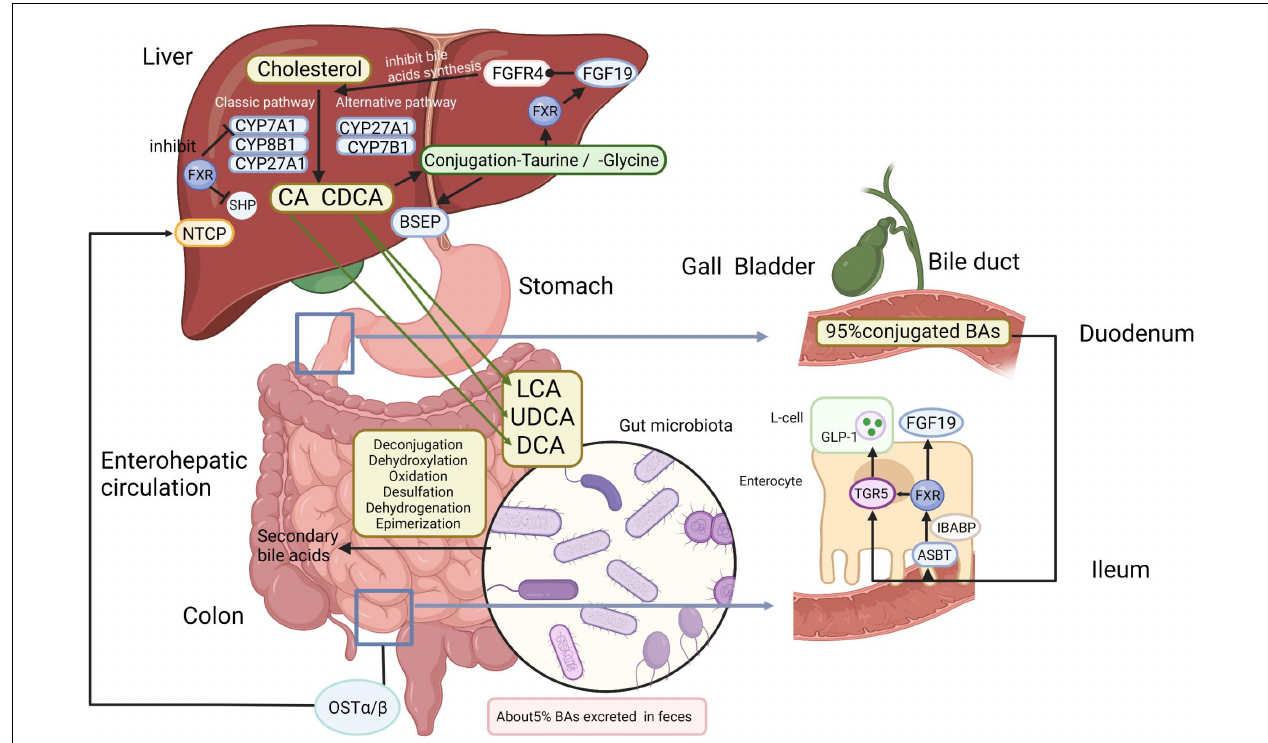
FIGURE 1 | Bile acids (Bas) metabolism and enterohepatic circulation. In the liver, primary BAs (CA and CDCA) are synthesized by enzymatic catalysis from cholesterol. CYP7A1 initiates the classical synthesis pathway and the ratio of CA/CDCA is regulated by CYP8B1. CYP27A1 and CYP7B1 are mainly responsible for the alternative synthesis pathway. Then conjugated CA/CDCA with taurine or glycine are excreted across the canalicular (apical) membrane into the bile by the BSEP and stored in the gallbladder before being released to the duodenum, where primary BAs are transformed into secondary BAs by gut microbiota via deconjugation, dehydroxylation, oxidation, desulfation, dehydrogenation, and epimerization. Most BAs are reabsorbed in the ileum by the ASBT and then connected to the IBABP. After that, BAs are transported to the portal vein via OST α / β and are taken up mainly by NTCP. In enteroendocrine cells, FXR enables TGR5 to induce the secretion of GLP-1 in intestinal L-cells. The combination of BAs to FXR not only inhibits the FXR-SHP pathway, accelerating lipid synthesis, but also induces FGF19 in the liver and ilea, and FGF19 binds to the FGFR4 on the hepatocytes, inhibiting BA synthesis. Approximately 5% of BAs are lost in fecal excretion. BAs, bile acids; CA, cholic acid; CDCA, chenodeoxycholic acid; CYP7A1, cholesterol 7 α -hydroxylase; CYP8B1, sterol 12 α -hydroxylase; CYP27A1, sterol 27-hydroxylase; CYP7B1, oxysterol 7 α -hydroxylase; BSEP, bile salt export pump; ASBT, apical sodium-dependent bile acid transporter; IBABP, ileal bile acid-binding protein; OST, organic solute transporter; NTCP, sodium taurocholate co-transporting polypeptide; FXR, farnesoid X receptor; TGR5, Takeda G protein-coupled receptor 5; GLP-1, glucagon-like peptide-1; SHP, small heterodimer partner; FGF19, fibroblast growth factor 15/19; FGFR4, fibroblast growth factor receptor 4. Created with